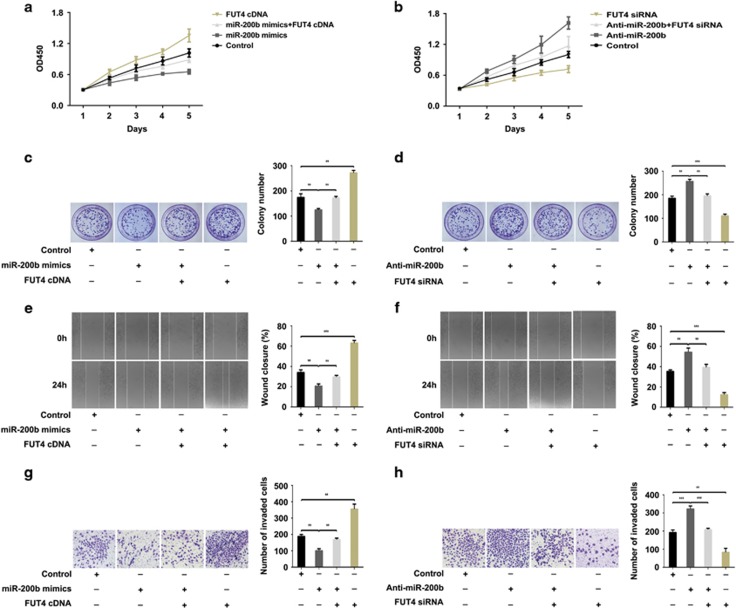
miR-200b inhibits the proliferation and invasion by suppressing FUT4 expression in MDA-MB-231 cells. MDA-MB-231 cells were transfected with miR-200b mimics and FUT4 cDNA or co-transfected with miR-200b mimics and FUT4 cDNA, respectively. (a) CCK-8 assay for cell proliferation. (c) Colony-formation assay. Representative images and statistical analysis are shown. (e) Wound-healing assay. Representative images and wound closure percentage are shown. (g) Transwell assay. Representative images and the number of invaded cells were statistically analyzed. MDA-MB-231 cells transfected with Anti-miR-200b and FUT4 siRNA or co-transfected with Anti-miR-200b and FUT4 siRNA, respectively. (b) CCK-8 assay for cell proliferation. (d) Colony-formation assay. Representative images and statistical analysis are shown. (f) Wound-healing assay. Representative images and wound closure percentage are shown. (h) Transwell assay. Representative images and the number of invade cells were statistically analyzed. **P<0.01, ***P<0.001.